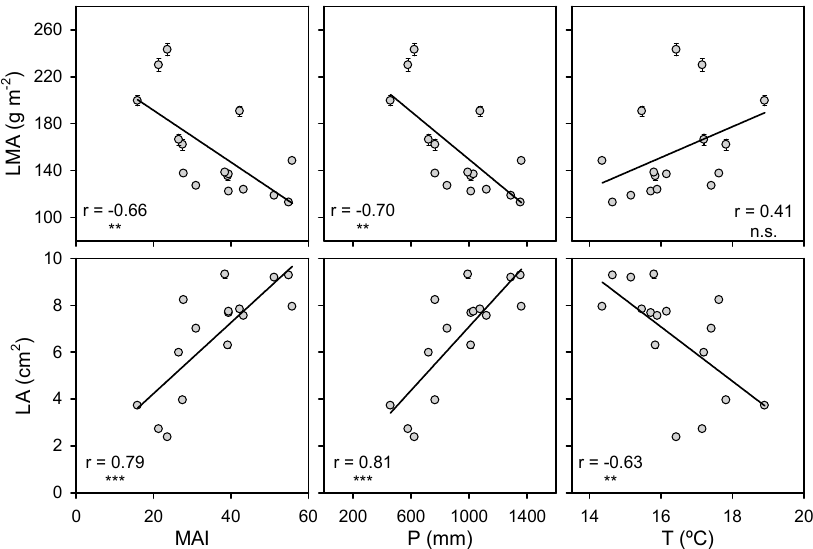
Figure 4. Relationships between leaf mass per area (LMA), leaf area (LA) and the climatic variables: De Martonne aridity index (MAI), annual precipitation (P) and annual mean temperature (T), for the 16 Quercus suber populations (** p < 0.01; *** p < 0.001; n.s. means not significant).